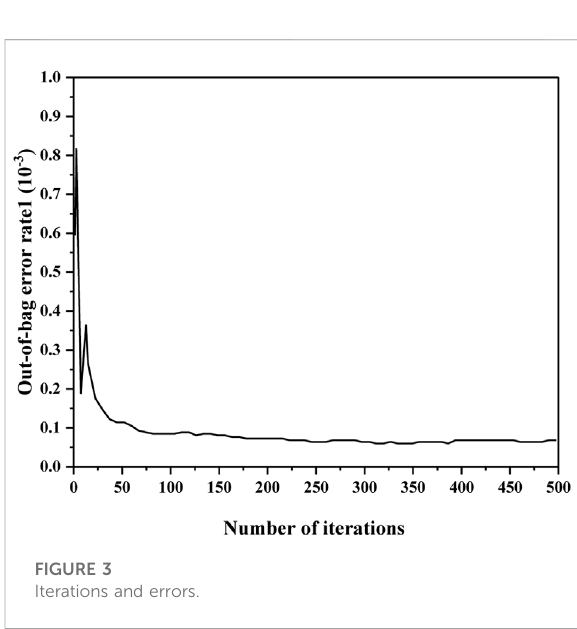
FIGURE 3 Iterations and